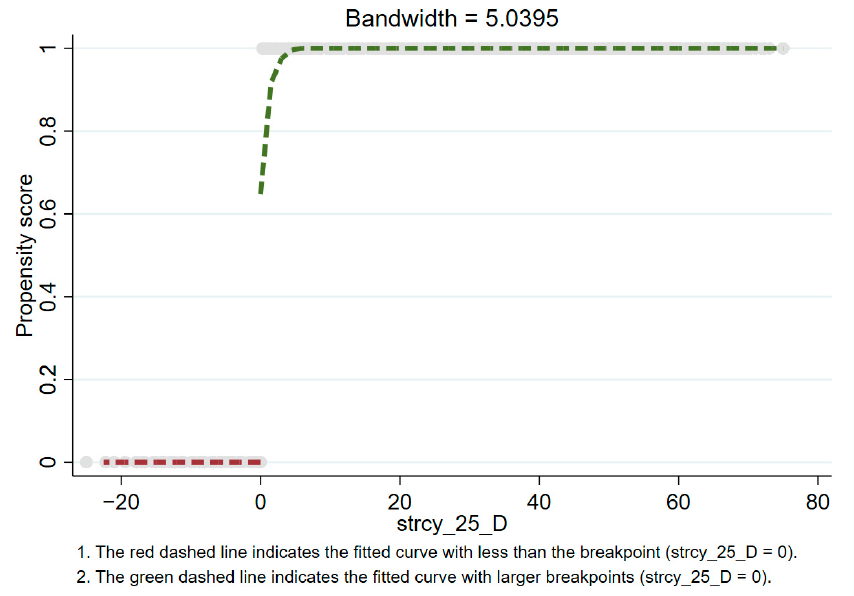
Figure 4. Propensity score at stringency = 25 (based on fuzzy breakpoint regression).